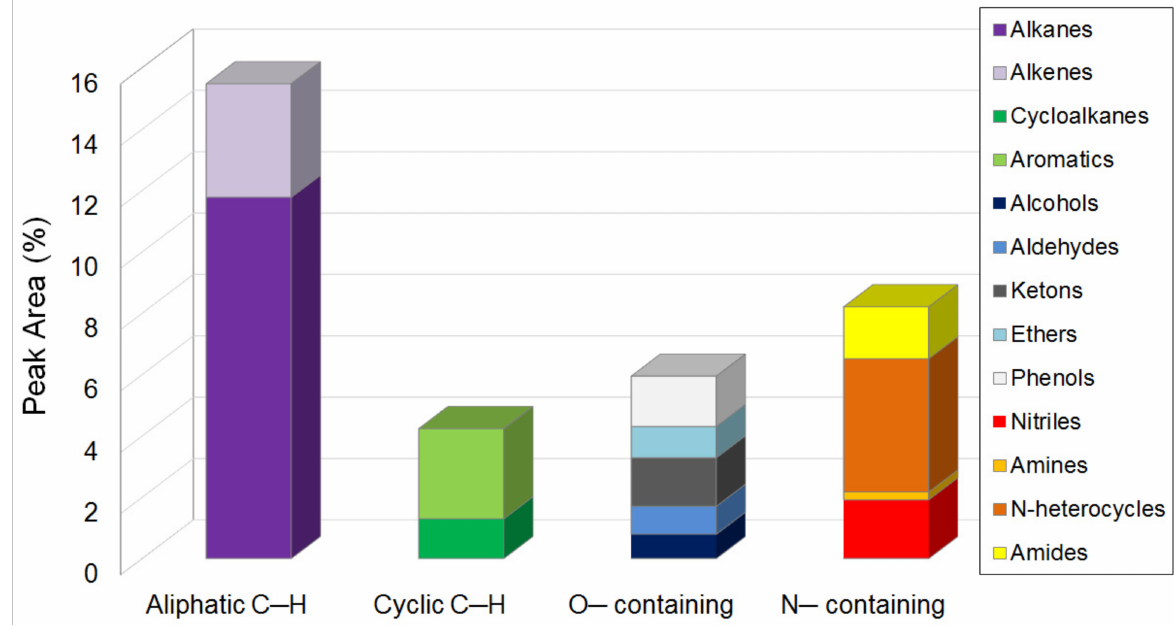
Figure 5. Chemical composition of the oil fraction from